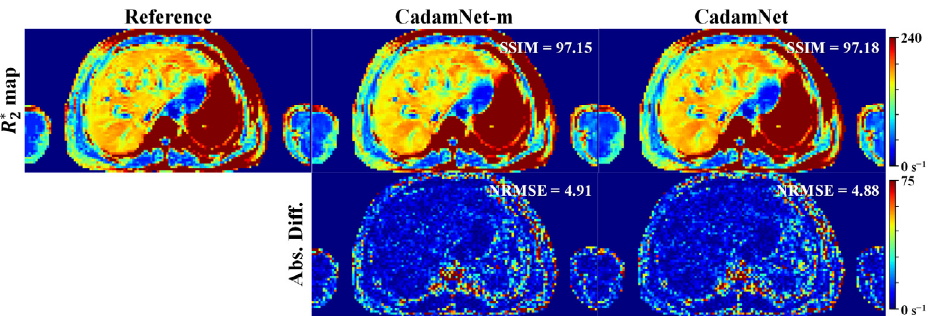
Figure 5. R2* maps for the simulated testing dataset with Rician noise ( σ g = 15). Top: Reference of R2* map and simulated noisy T2*-weighted images at three different echo times (ms). Bottom: R2* maps reconstructed using M 1 NCM, PCANR, MappingNet, and the proposed CadamNet methods, and the absolute difference maps are shown below the corresponding R2* maps. The SSIM of each R2* map is shown in its bottom right corner, and the NRMSE is shown in the absolute difference map.